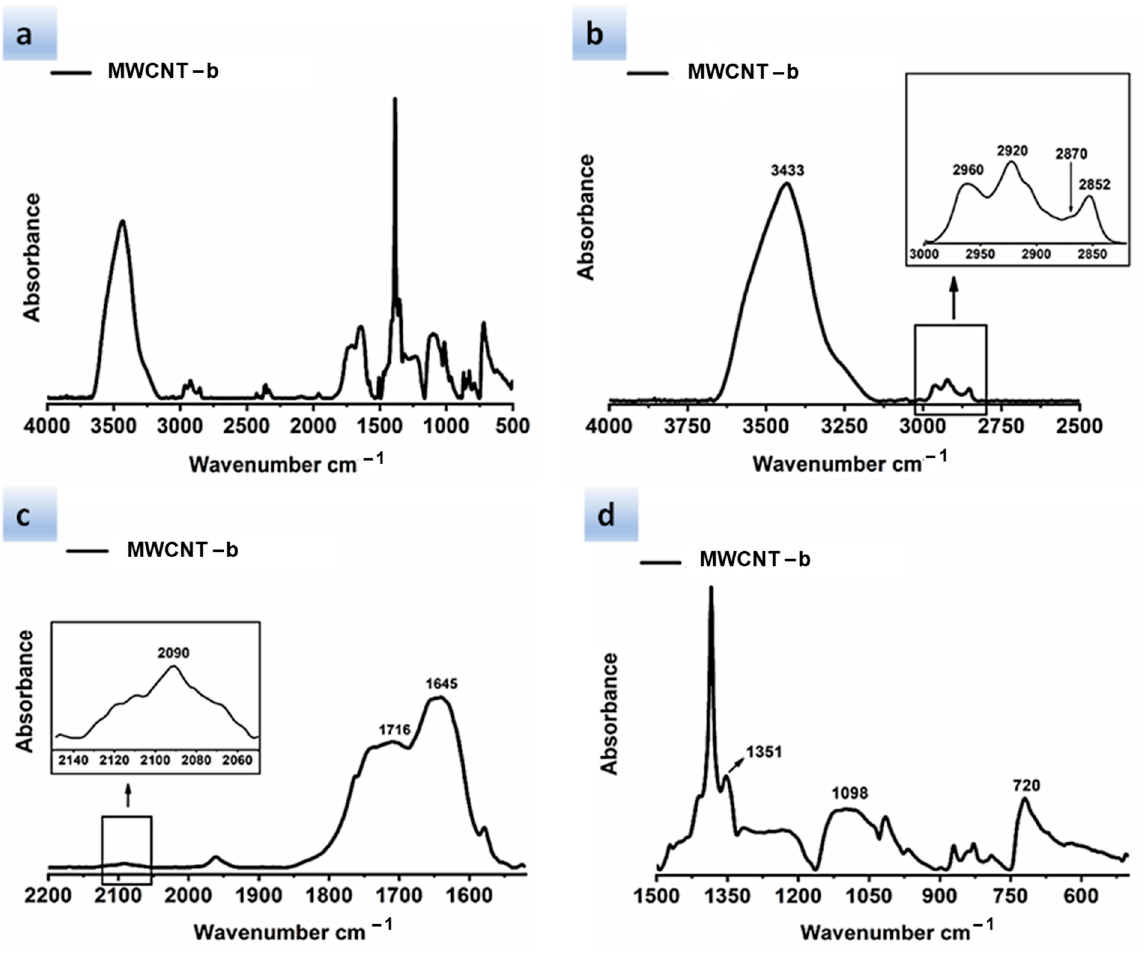
Figure 5. FTIR spectrum of MWCNT–b shown at different spectral ranges of wavelengths: ( a ) spectral range 4000–500 cm − 1 ; ( b ) spectral range 4000–2500 cm − 1 with inset at higher magnification; ( c ) spectral range 2200–1550 cm − 1 with inset at higher magnification; ( d ) spectral range 1500–525 cm − 1 .